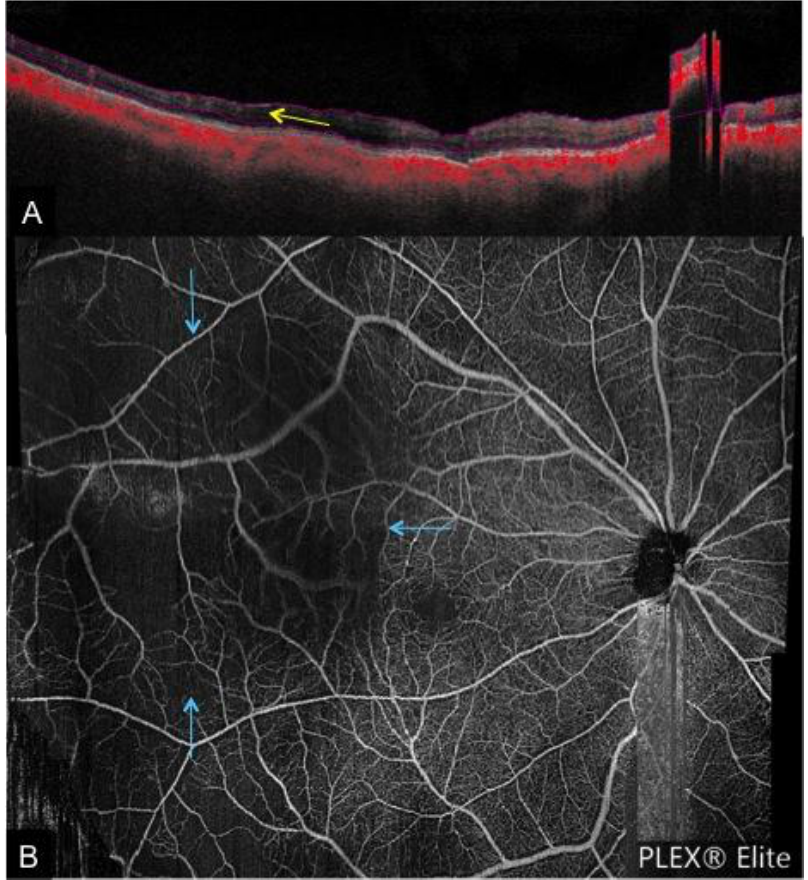
Figure 8. A case of ocular ischemic syndrome. ( A ): Cross-sectional OCTA showing temporal thinning of the retina layer in the posterior pole (indicated by the yellow arrow) along with a reduced flow signal. ( B ): Corresponding en face OCTA demonstrating reduced flow in the temporal region (blue